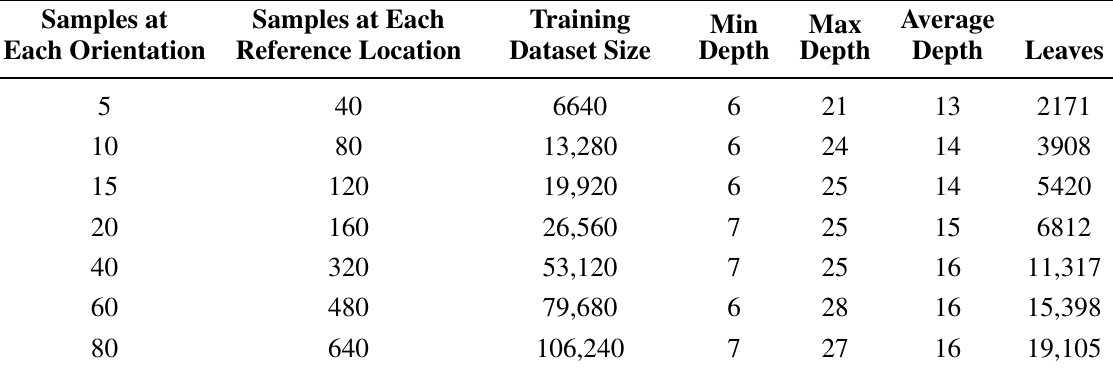
Table 2. Decision tree depth vs. the training